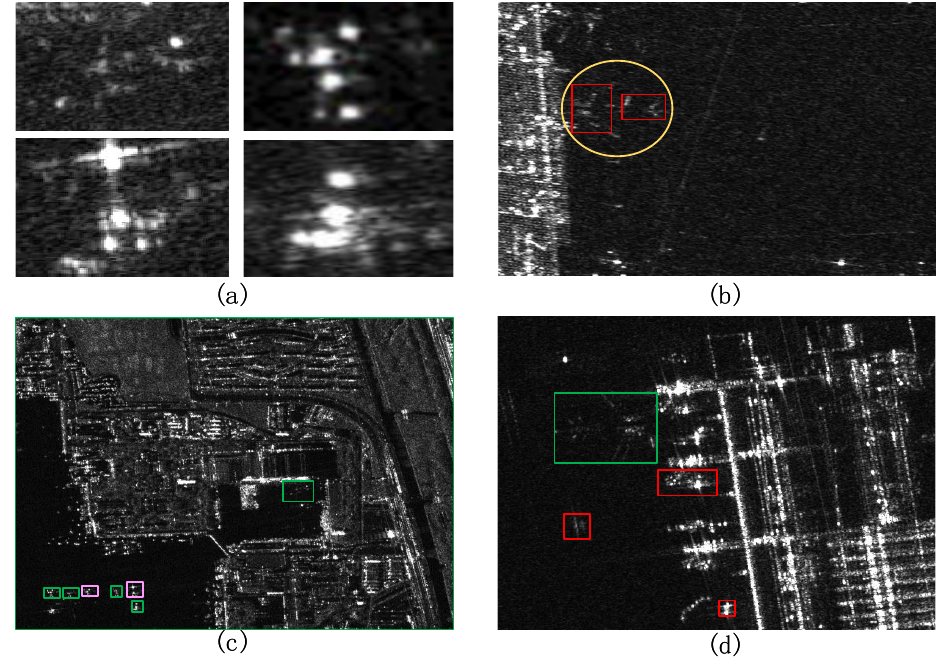
Figure 1. Detection effect of the general detection algorithm. The green boxes, pink boxes, red boxes, and yellow ellipse represent the correct predictions, missing detections, false alarms, and complete aircrafts, respectively. ( a ) Aircraft targets. ( b ) Problems of discrete detection. ( c ) Aircraft targets of various sizes. ( d ) Problems of complex background